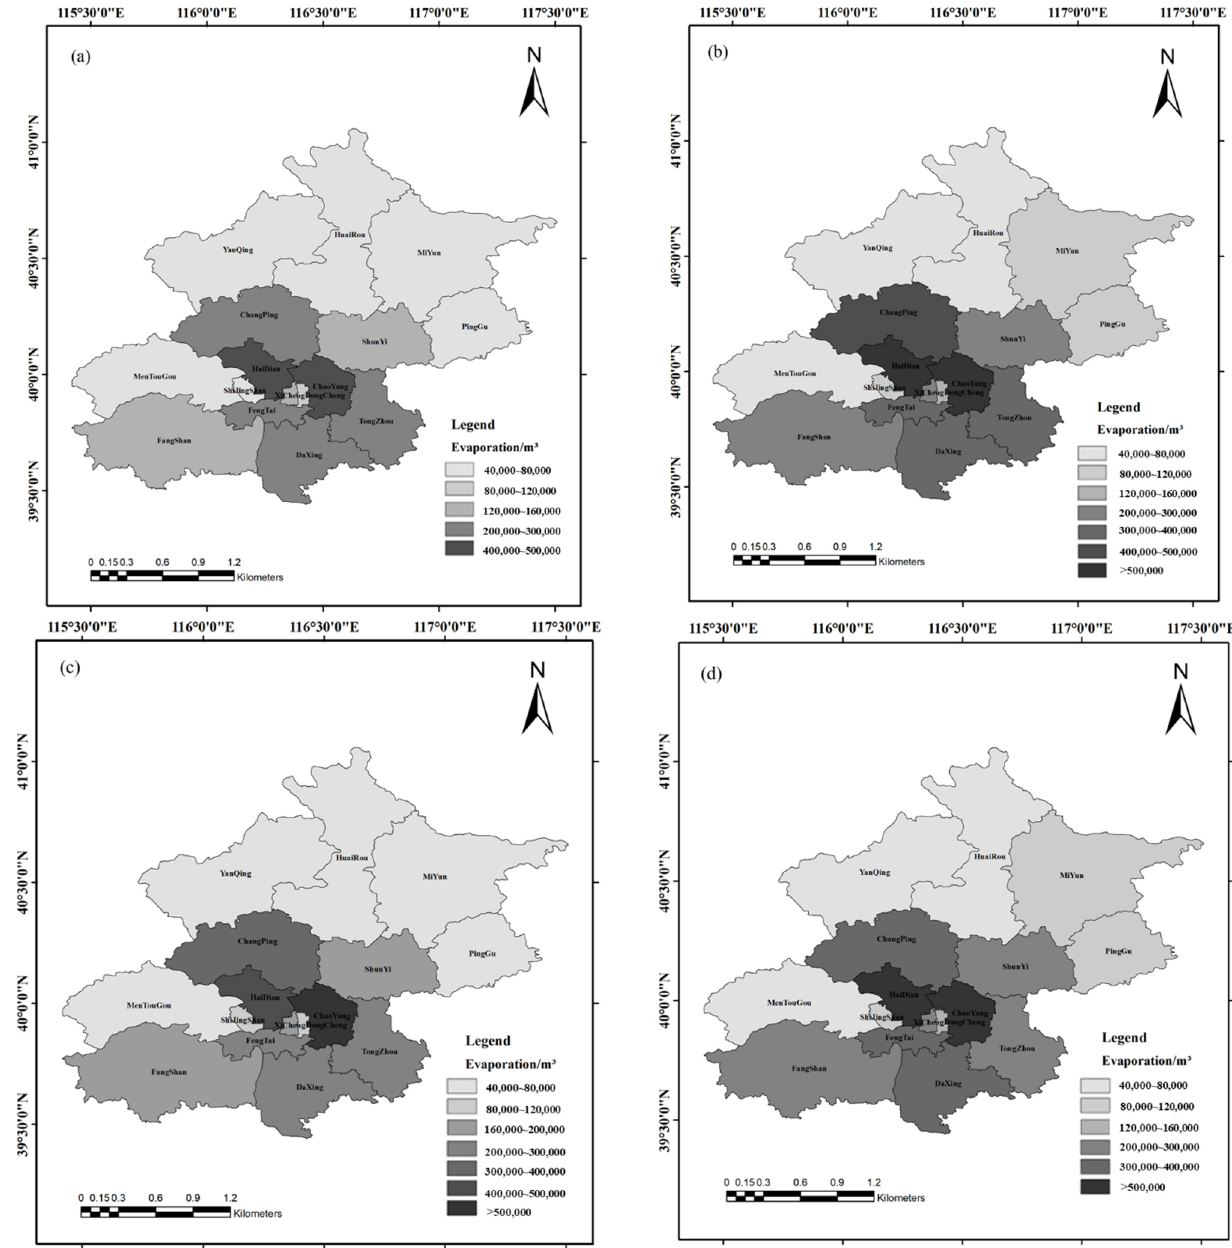
Figure 3. Distribution map of human body perspiration in different seasons of Beijing in 2020. ( a ) Spring; ( b ) summer; ( c ) autumn; ( d ) winter.